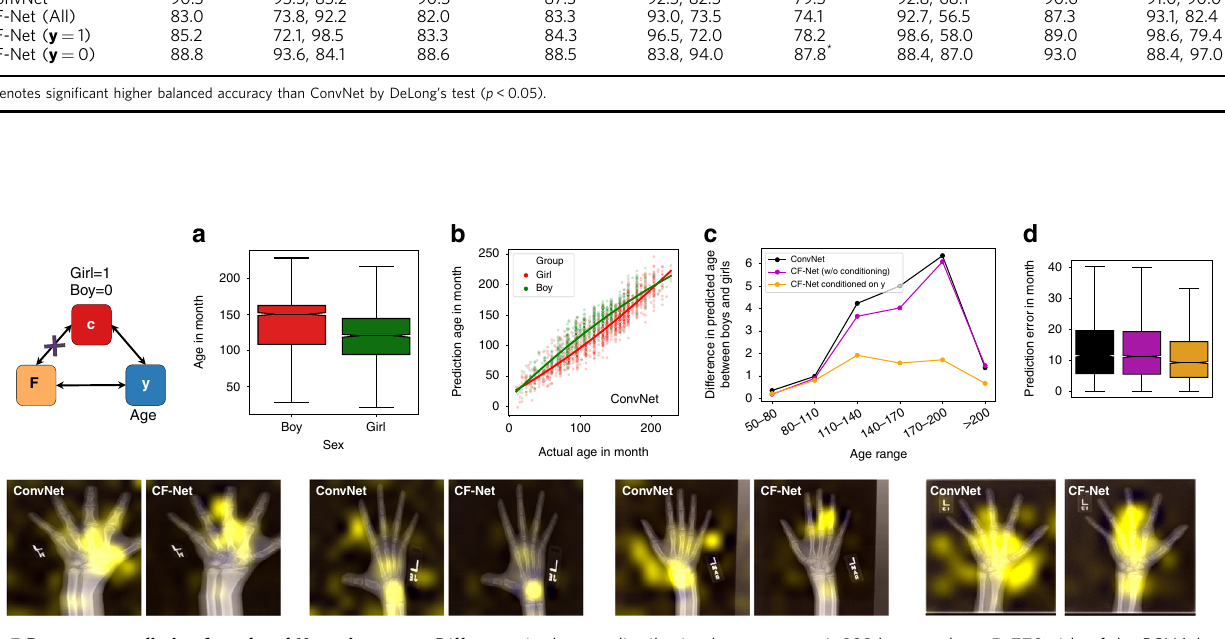
Fig. 5 Bone-age prediction from hand X-ray images. a Difference in the age distribution between n = 6, 833 boys and n = 5, 778 girls of the RSNA bone- age dataset ( p < 0.0001, two-tailed two-sample t -test). b Ground truth vs. predicted age of the ConvNet. ConvNet tended to predict higher age for girls than boys, indicating a confounding effect of sex. c This prediction gap between boys and girls was more pronounced in the age range of 110 – 200 months, but was signi fi cantly reduced by CF-Net, which modeled the dependency between F and c on a y -conditioned cohort. d Absolute prediction error (in months) of n = 3, 153 testing subjects produced by ConvNet and CF-Net with (or without) conditioning. Boxplots are characterized by minimum, fi rst quartile, median, third quartile, and maximum. CF-Net with conditioning resulted in the most accurate prediction ( p < 0.0001, two-tailed two-sample t -